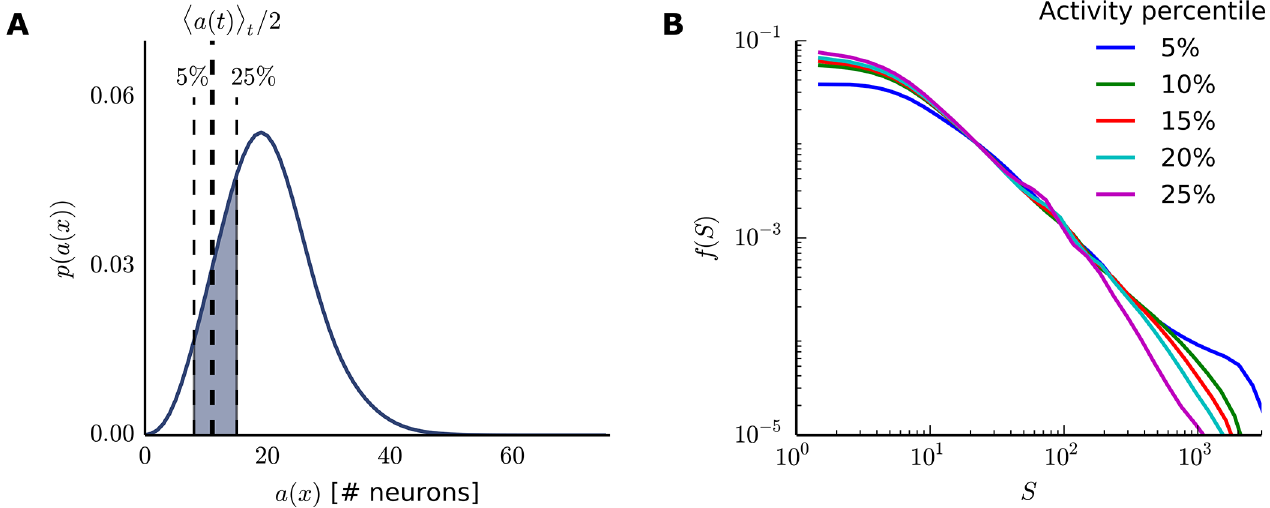
Fig 3. Robustness to choice of activity threshold. (A) Activity distribution function for a SORN with N E = 200. The shadedarea shows the approximate region where the power-laws hold. The activity peak, as expecteddue to the target firing rate, is 10% of the number of excitatory neurons. (B) Avalanchesize distribution for different activity thresholds θ set as activity percentiles.Althoughshowingdifferent exponents, the power-laws hold for different thresholds (as seen, for example,for θ set at the 5th or 10th percentiles of the activity distribution).Curves show combineddata from 50